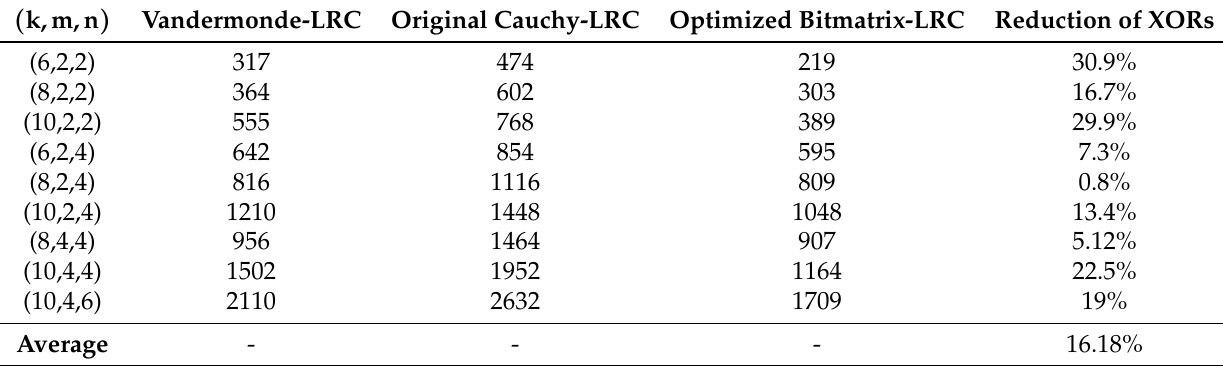
Table 2. Total Number of XOR’s.